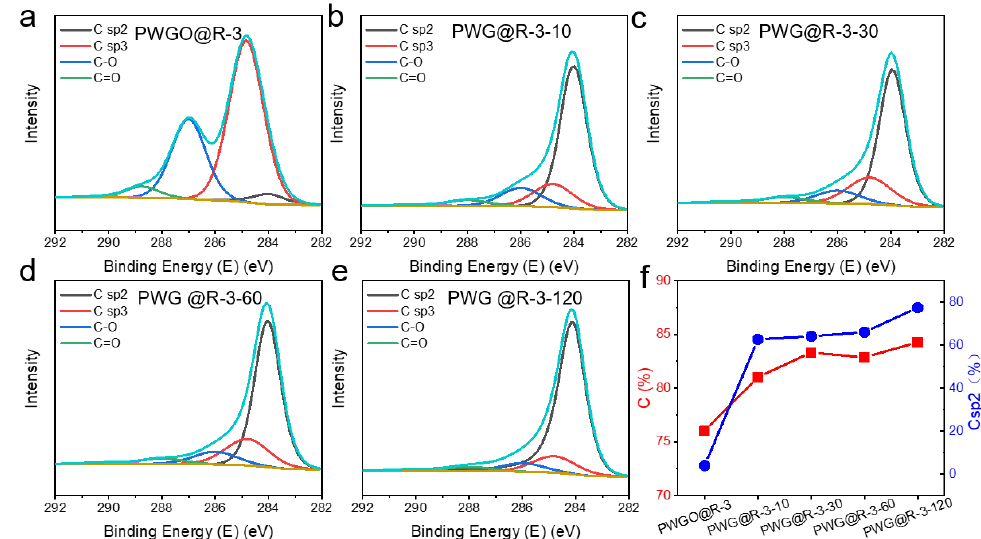
Figure 6. High-resolution XPS C 1s spectra of ( a ) WGO@R-2, ( b ) WG@R-2-10, ( c ) WG@R-2-30, ( d ) WG@R-2-60, and ( e ) WG@R-2-120. ( f ) The trend line of the content that is C in all atoms, and the content that is C in sp 2 in all C atoms.